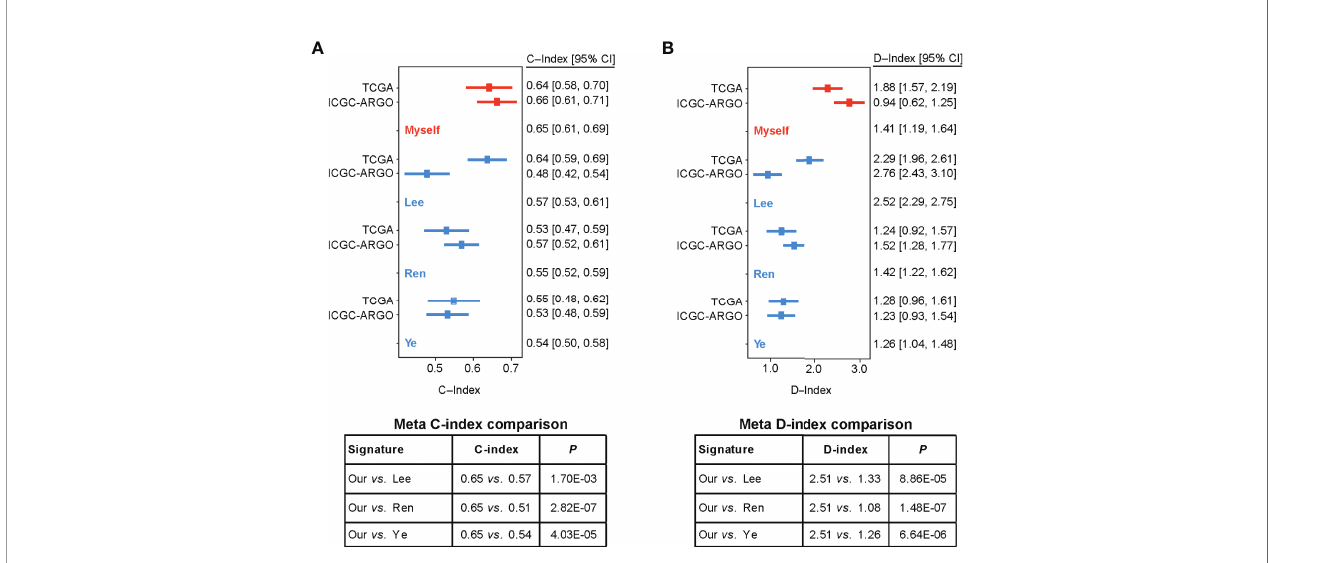
FIGURE 5 | Forest plot reporting of C-index and D-index of various prognostic signatures among the different cohorts. (A) The concordance indices (C-index) for TCGA and ICGC-ARGO cohorts. Our model achieved the highest C-index compared to the three reported models (0.65 vs. 0.51-0.57). (B) The robust hazard ratio (D-index) for TCGA and ICGC-ARGO cohorts. Our model achieves the highest D-index compared to the three reported models (2.51 vs.